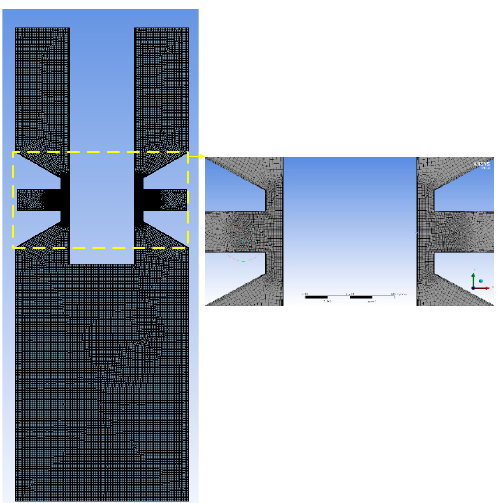
Figure 2. Grid model with a grid size of 0.012 and the flapper at the zero position when L 1 = 0.02. Table 3. Grid